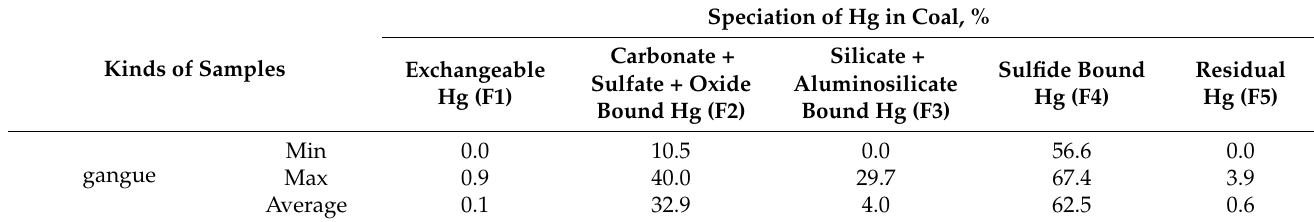
Table 9. Hg speciation in 12 gangue